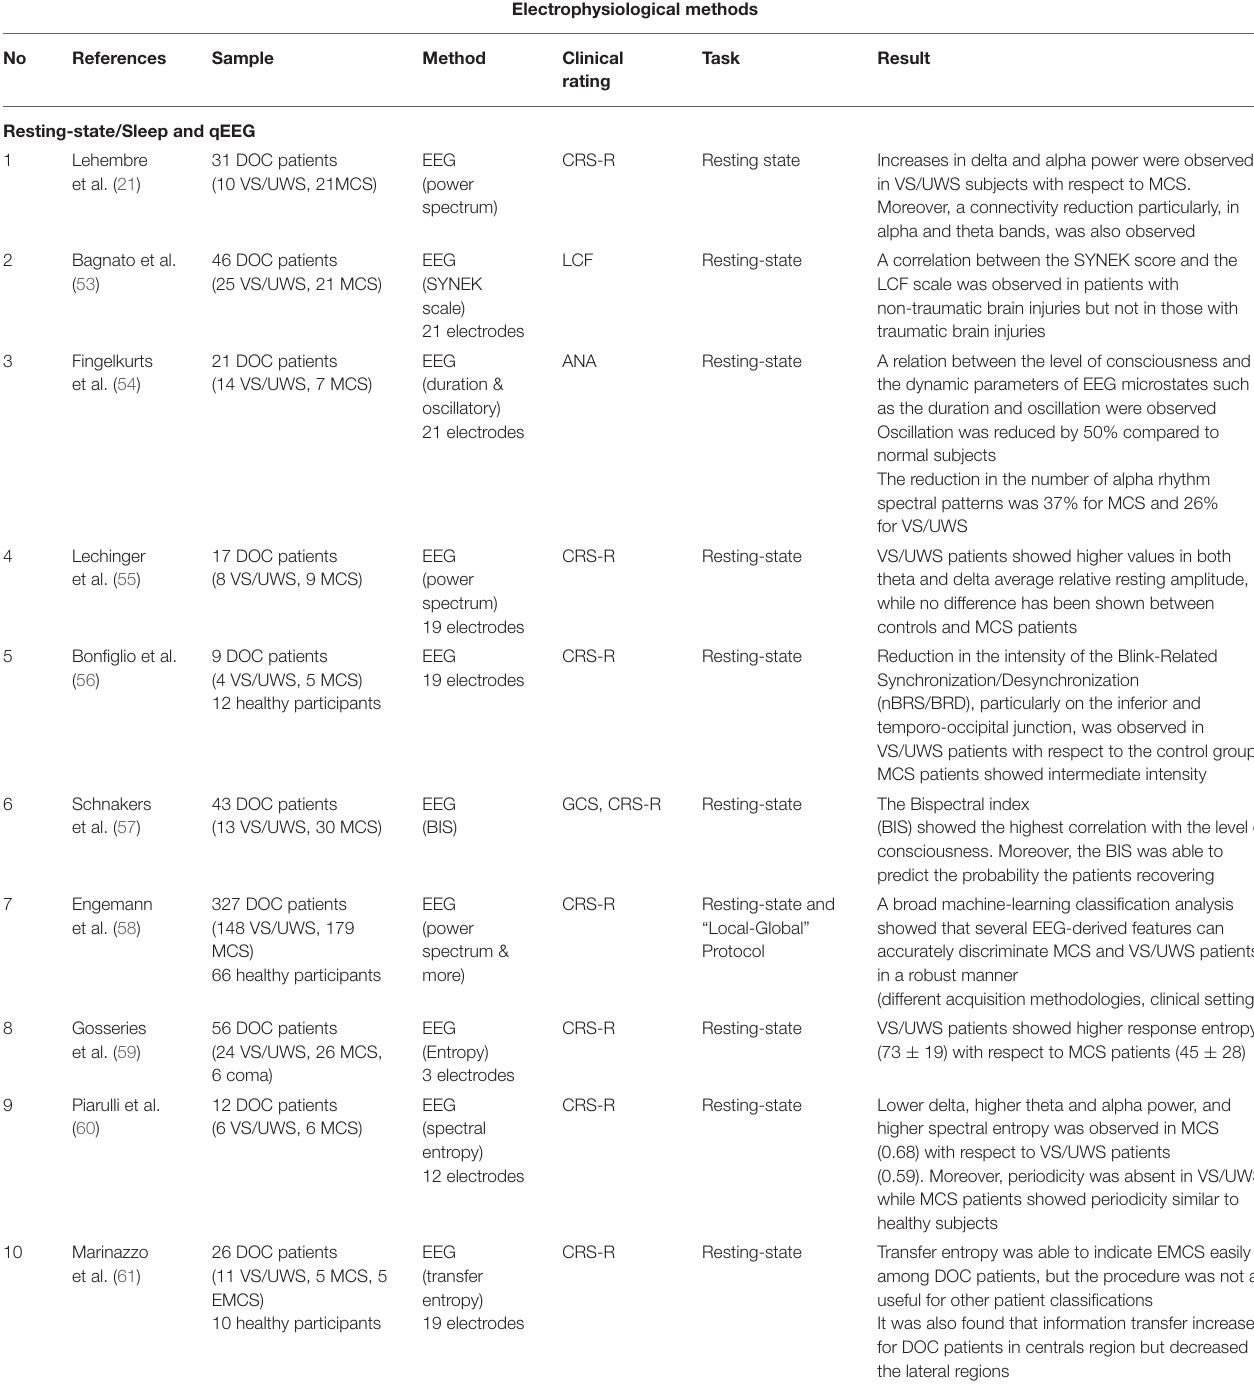
TABLE 3 | Studies were reviewed and included in the